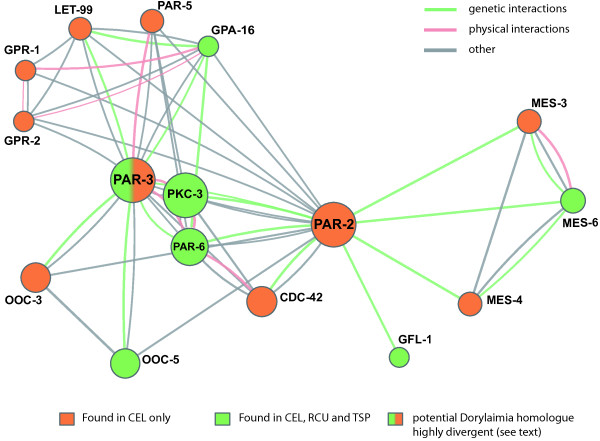
The network of proteins interacting with PAR-2 and PAR-3 in Caenorhabditis elegans and their orthologues in Romanomermis culicivorax and Trichinella spiralis. The network cartoon is based on the core polarity pathway extracted from WormBase, derived from both genetic and physical interactions. PAR-2 was missing from the dorylaim nematodes, as were the directly connected MES-3 and MES-4 genes. The R. culicivorax PAR-3-like protein was not retrieved as an orthologue of C. elegans and T. spiralis PAR-3 proteins, but was identified employing sensitive sequence similarity search. See Table 3 for additional proteins interacting with PAR proteins and their presence-absence patterns.